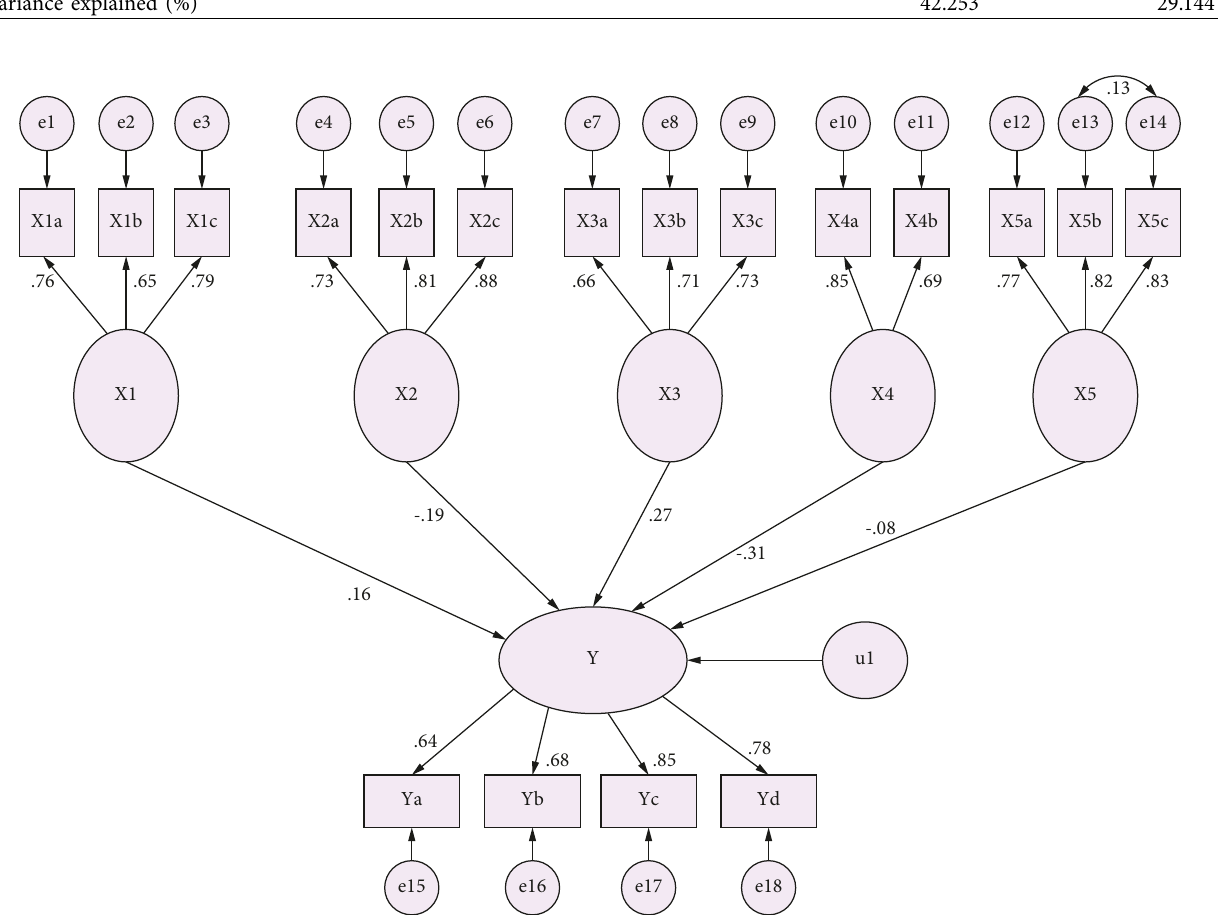
Figure 3: SEM and parameter estimation.